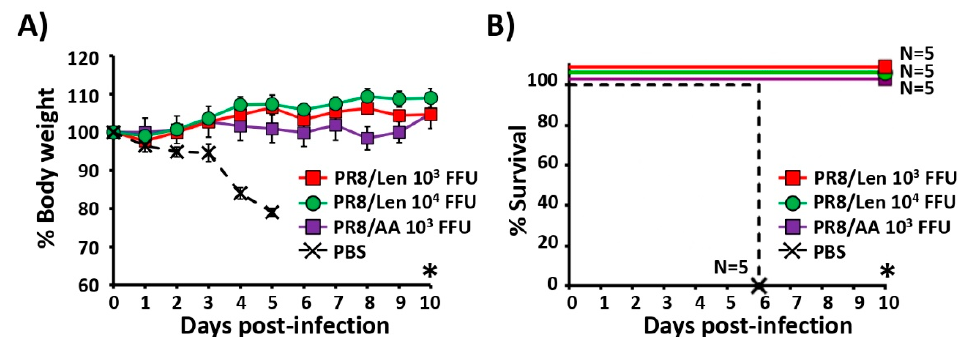
Protection e ffi cacy of PR8 / AA and PR8 / Len against homologous viral challenge: Figure 7. Protection efficacy of PR8/AA and PR8/Len against homologous viral challenge: Six-to- Six-to-eight-week-old female C57BL / 6 mice ( n = 5) were infected i.n. with 10 3 and 10 4 FFU of eight-week-old female C57BL/6 mice ( n = 5) were infected i.n. with 10 3 and 10 4 FFU of PR8/Len and PR8 / Len and 10 3 FFU of PR8 / AA viruses, or mock vaccinated (PBS). At 15 days p.i., mice